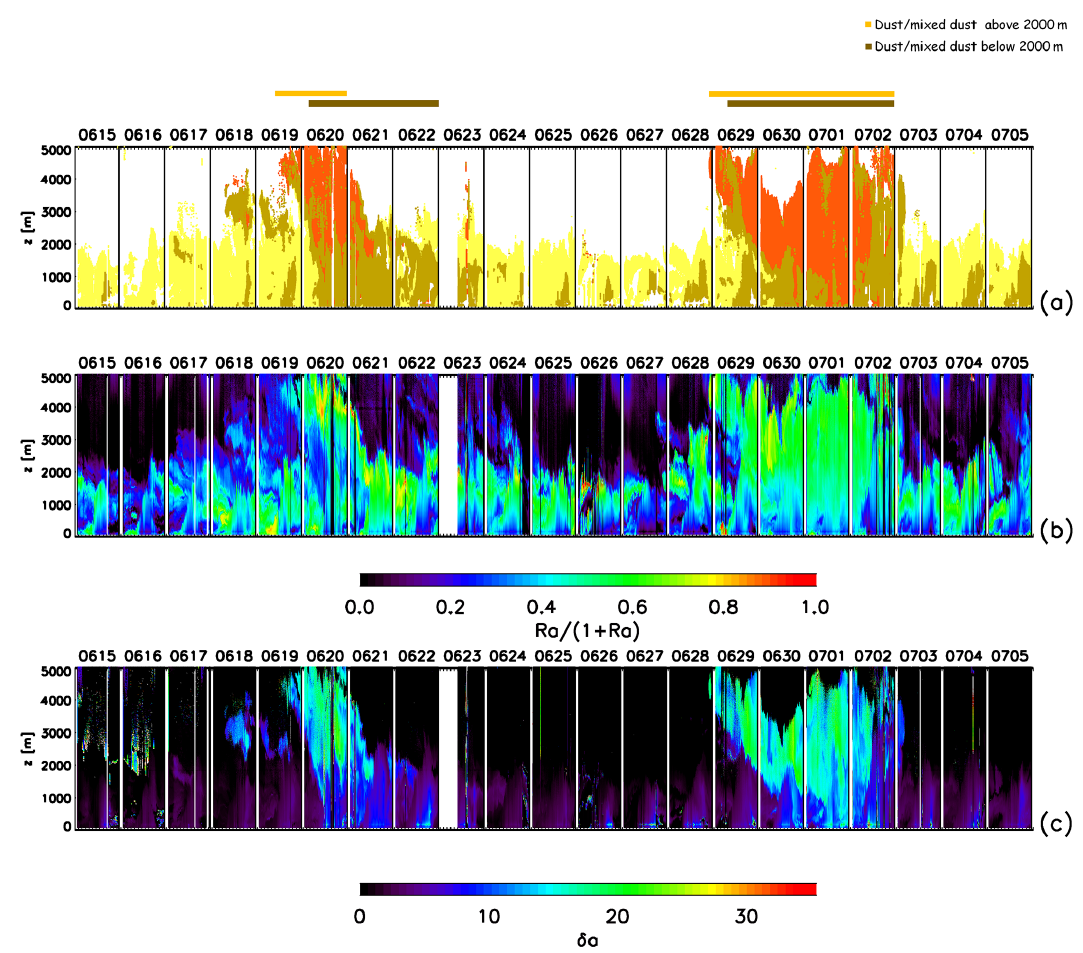
Figure 2. Lidar observations along the whole campaign. (a) Vertical profiles of aerosol particle types resulting from the classification methodology described in Sect. 3: non-depolarizing aerosol (yellow), depolarizing aerosol (orange) and intermediate depolarization aerosol (brown). (b) Vertical profiles of R a / ( R a + 1). (c) Vertical profiles of δ a . The coloured bars above panel (a) give reference for the presence of dust or mixed dust above 2000m (orange bar) and below 2000m (brown bar) to compare with the in situ measurements. See also Figs. 3 and